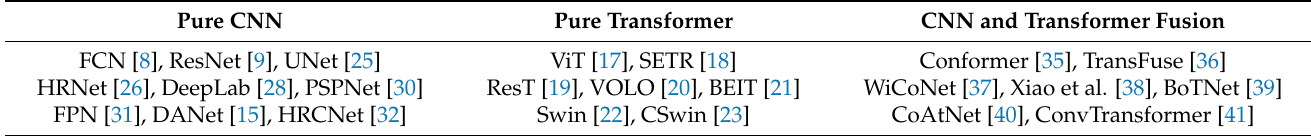
Table 1. Summary of related work.